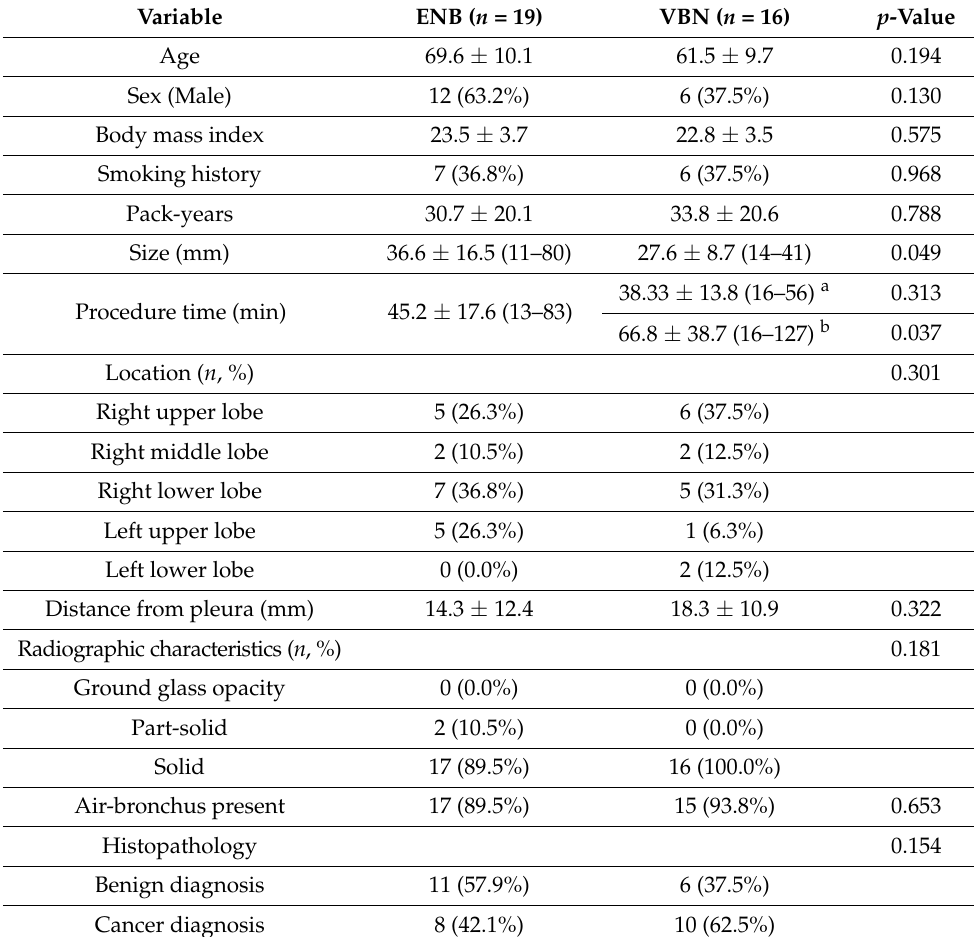
Table 2. Comparison of the two approaches.